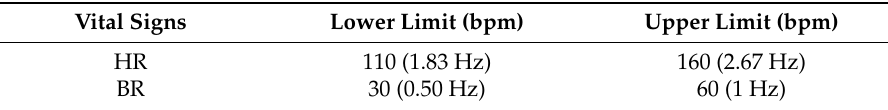
Table 1. Band of interest.